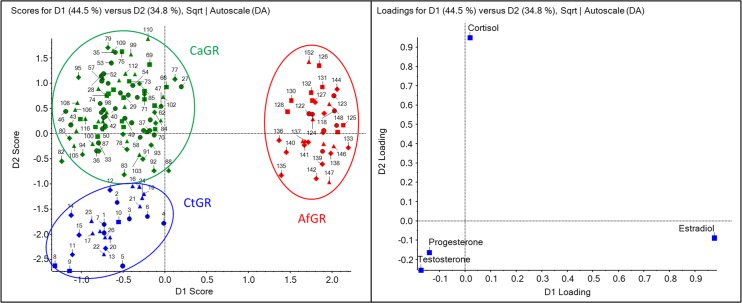
PCA-DA score (left) and loading (right) plots for all serum samples studied.Data collection of CtGR: control golden retriever (data in blue); CaGR: carrier golden retriever (data in green), and AfGR: affected golden retriever (data in red). Each symbol represents an estrous phase: anestrus (circle), proestrus (square), estrus (rhombus), and diestrus (triangle).